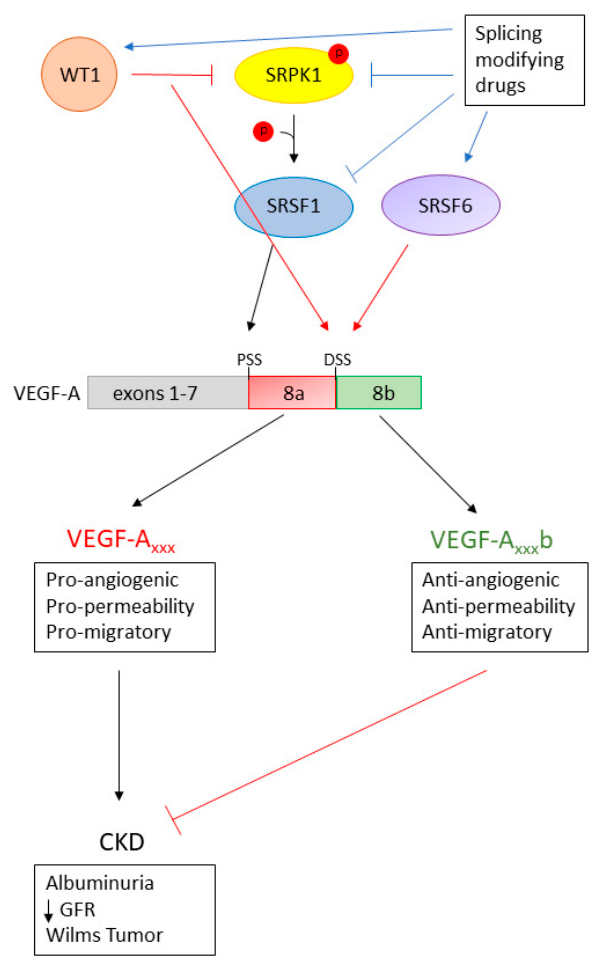
Figure 4. Switching VEGF-A splicing with splicing-modifying drugs for therapeutic benefit. SRPK1 is a key regulator of VEGF-A exon 8 splicing; therefore, it is an ideal target for therapeutic modulation of VEGF-A splicing to increase the VEGF-A xxx b isoform expression. Splicing-modifying drugs designed to up-regulate WT1 (thus initiating SRPK1 transcriptional repression), inhibit SRPK1 activation or increase the activation/expression of SRSF6, resulting in a splicing switch to increase the VEGF-A xxx b/VEGF-A xxx ratio. As such, they provide a novel therapeutic avenue in the treatment/prevention of chronic kidney disease. CKD: chronic kidney disease; GFR: glomerular filtration